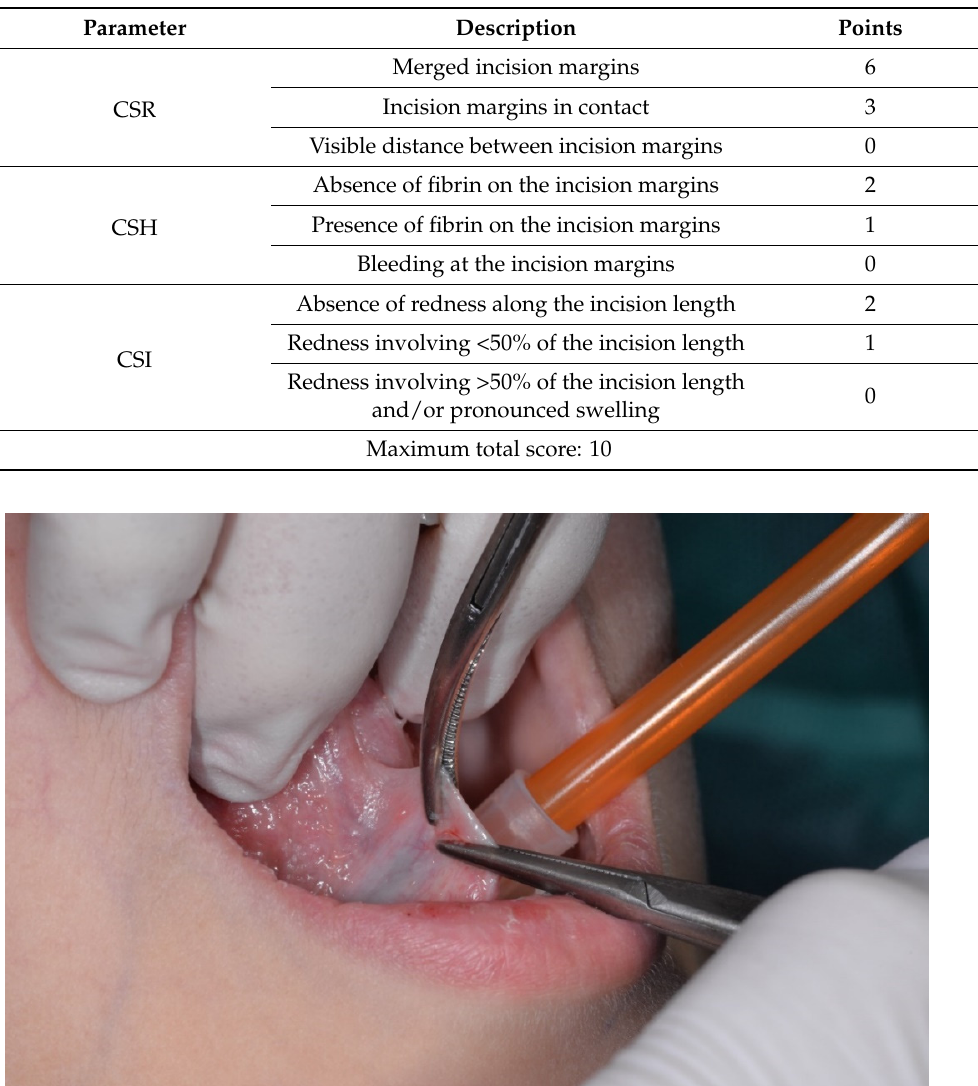
Figure 2. Starting the surgery using a 15c blade.